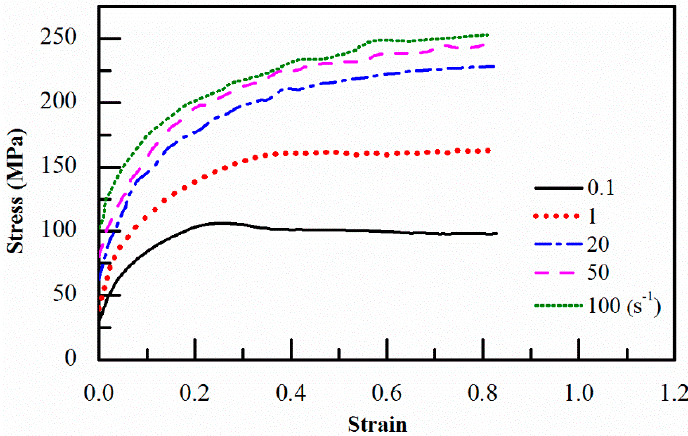
Figure 7. The flow curves of the SAE1016 at 900 °C.